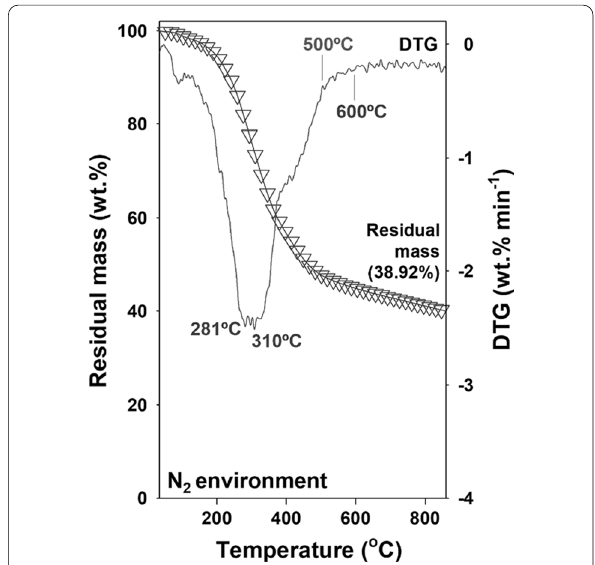
Fig. 4 Mass decay and DTG curves of SSR under N 2